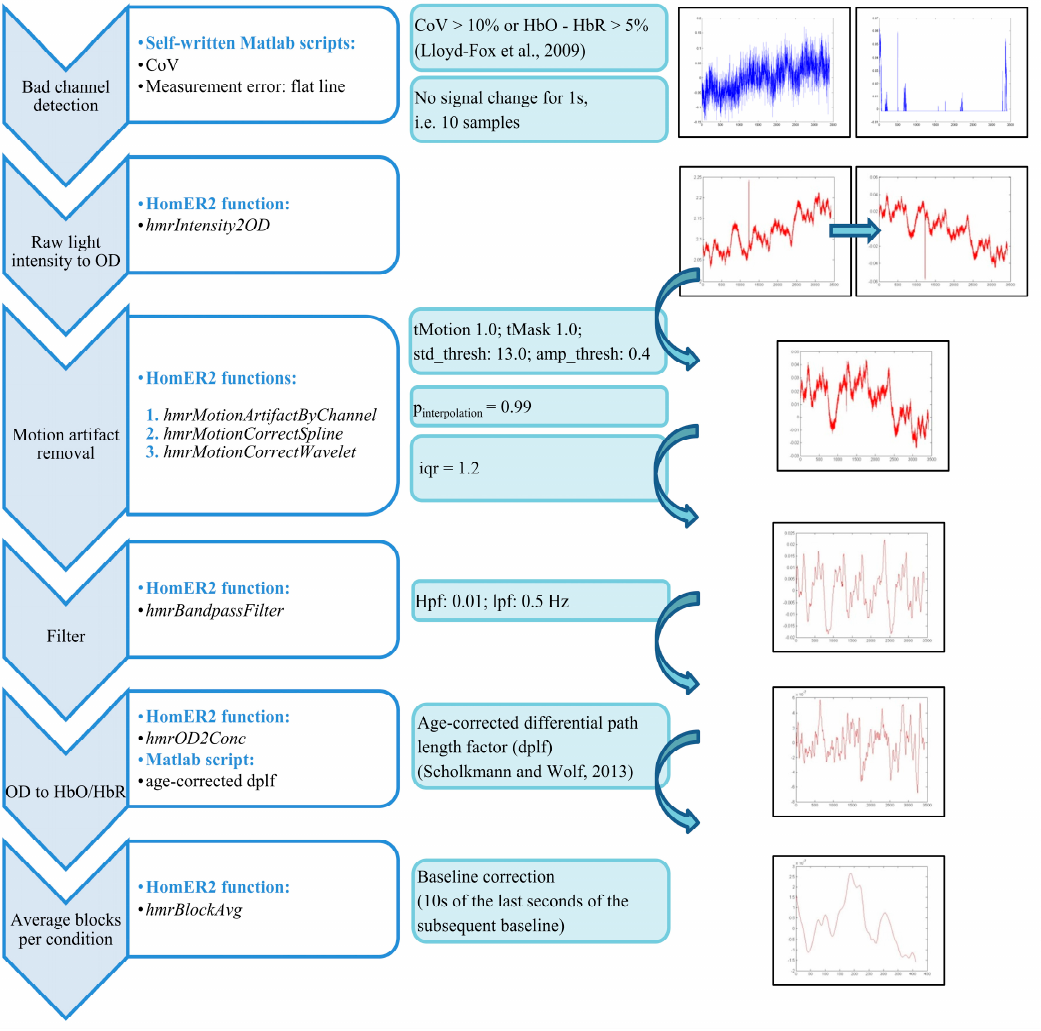
Figure 2. FNIRS preprocessing pipeline. Abbreviations: CoV, coe ffi cient of variation; HbO, oxygenated hemoglobin; HbR, deoxygenated hemoglobin; OD, optical density; lpf, low-pass filter; hpf, high-pass filter; dplf, di ff erential path length